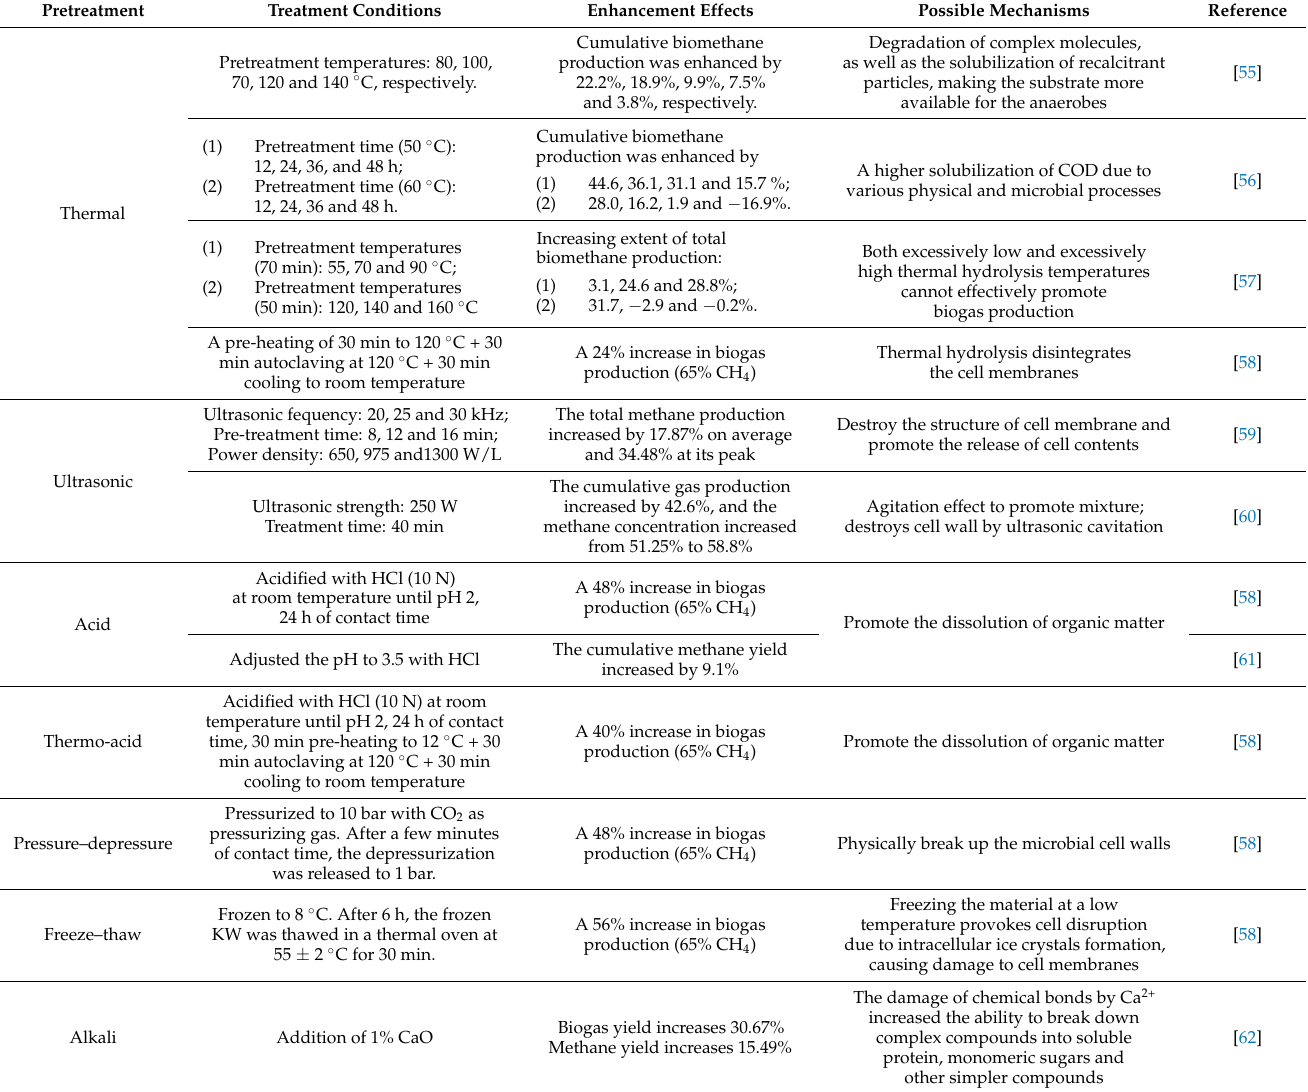
Table 1. Effect of different pretreatment methods on methanogenesis of kitchen